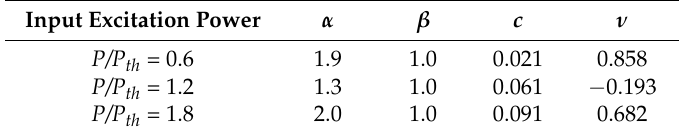
Figure 5. ( a – c ) 5000 intensity spectra of the Er-RFL system for each input power ( a ) below; ( b ) around; and ( c ) above the RL threshold; ( d – f ) Probability density functions (PDFs) P ( I ) of maximum intensities obtained from the data shown in ( a – c ). The best fits using Equation (7) are depicted in dotted lines and portrait Gaussian profiles ( d ) below and ( f ) above the threshold ( α = 2.0); and ( e ) a Lévy distribution ( α = 1.3) around the threshold. (Reproduced with permission from ref. [68]). Table 1. Summary of best fit parameters to Equation (7) for the intensity distributions of Figure 5d–f [68]. Input Excitation Power α